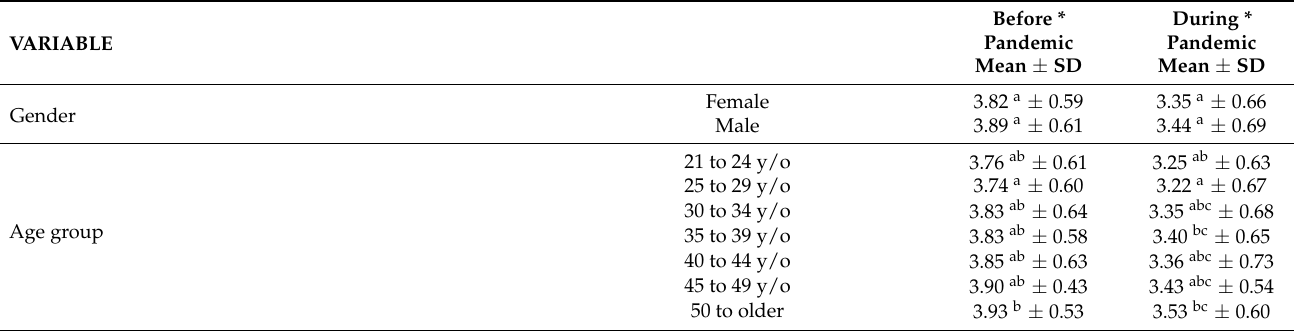
Table 2. Brazilian dietitians Quality of life by socioeconomic and demographic variables prior and in the course of the pandemic period ( n =